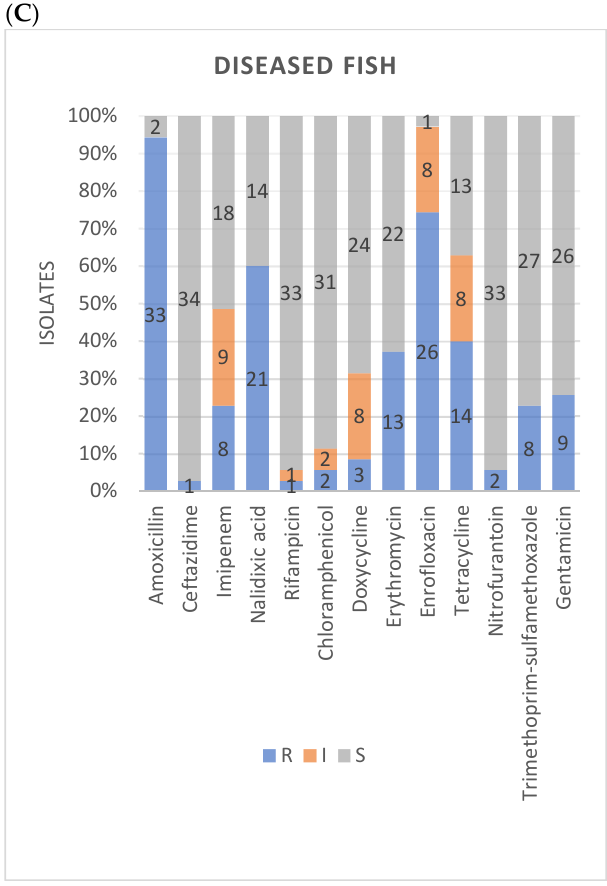
Figure 5. Antimicrobial susceptibility pattern of Aeromonas spp. isolated from different sample types; ( A ) Aquatic environment; ( B ) skin mucous of apparently healthy fish; ( C ) diseased fish (R—resistant, I—intermediate, S—susceptible).